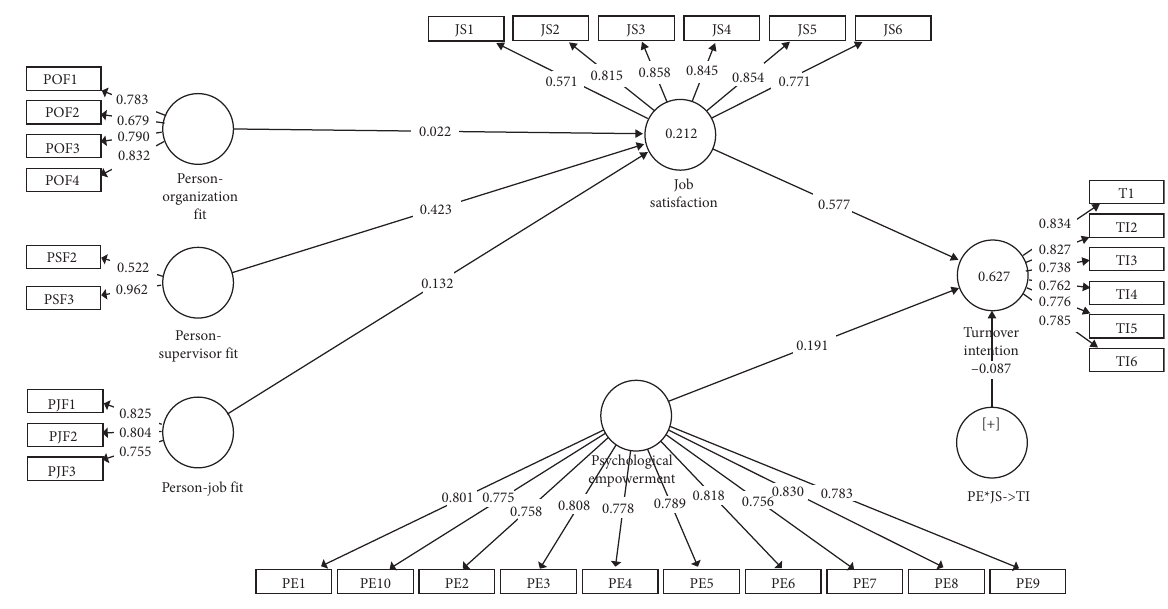
Figure 2: Measurement model.